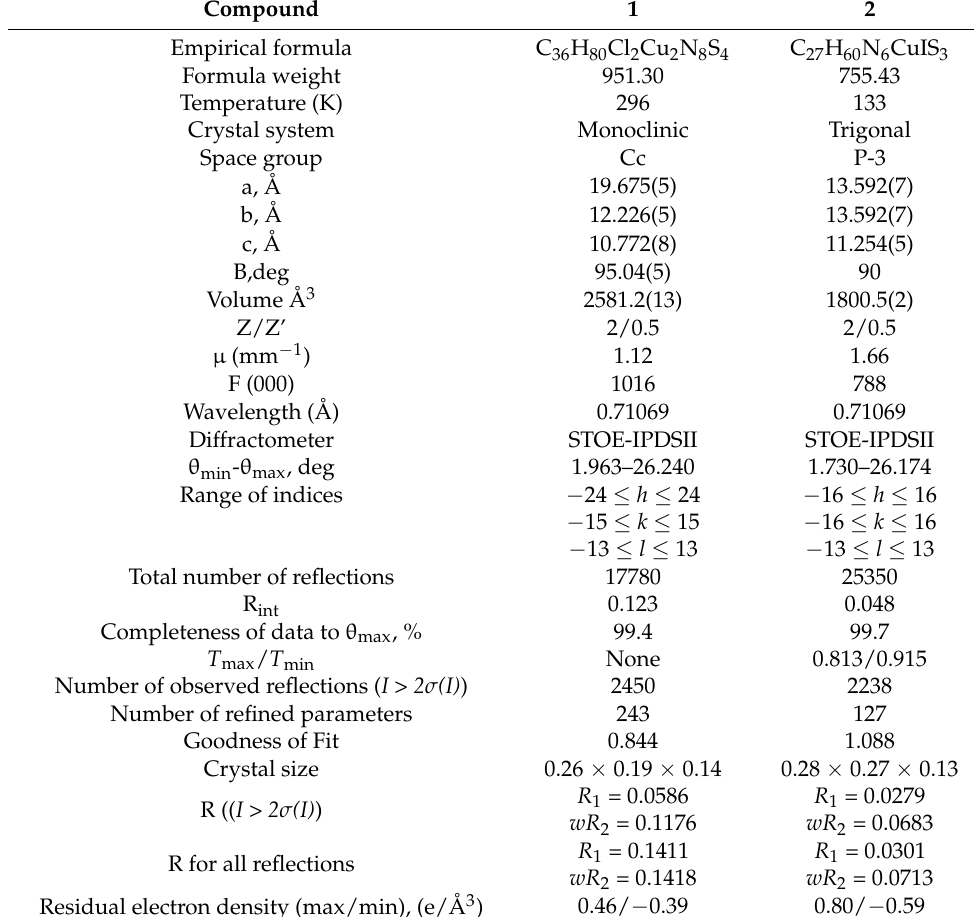
Table 1. Crystal structure solution and refinement parameters of complexes 1 and 2